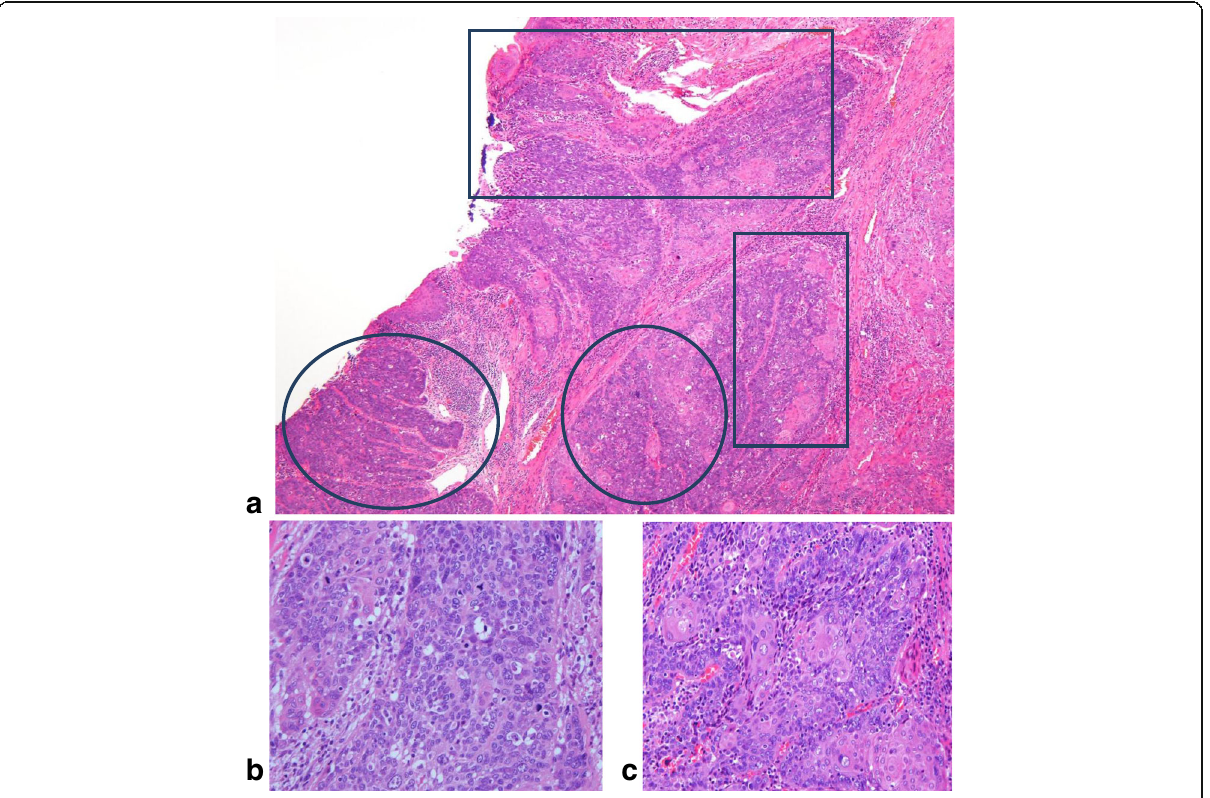
Fig. 2 a Histological findings of the specimen. Adenocarcinoma component (round line) and squamous cell carcinoma component (square line) are demonstrated. b Tumor cells with enlarged nucleus make solid or tubular structure (adenocarcinoma component). c In this area, tumor shows